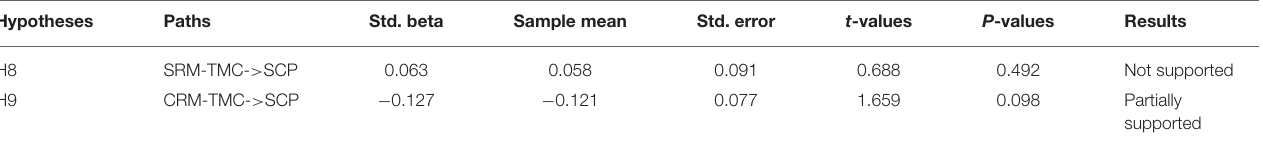
TABLE 8 | Indirection relationships between customer relationship management, supply chain performance, supplier relationship management, and top management commitments ( N = 208). Hypotheses